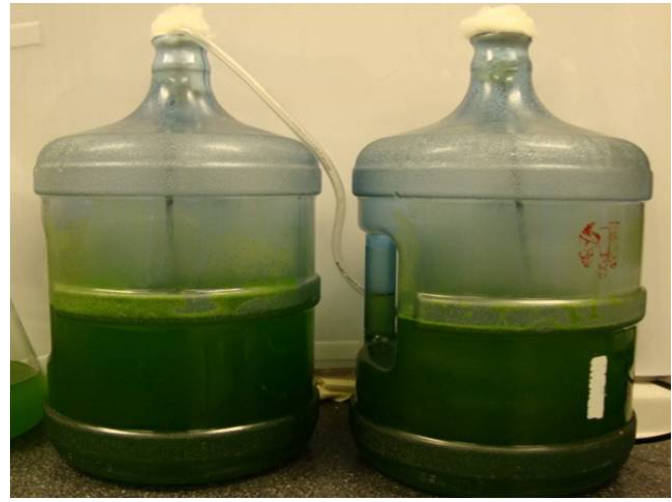
Figure 2. Growing FWM-CV for the emulsified water